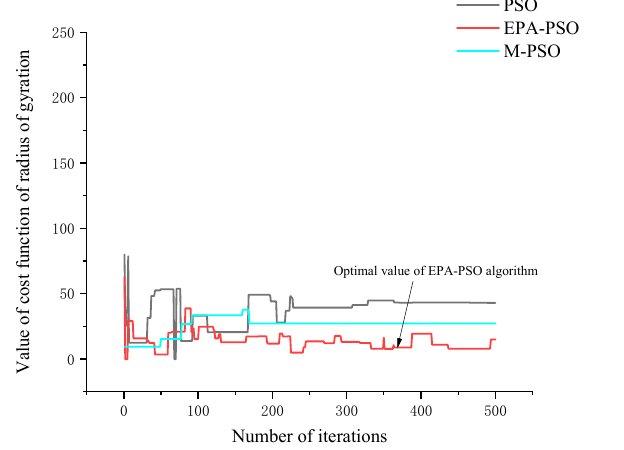
Figure 17. Numerical comparison of cost functions of radius of gyration after 200 iterations.